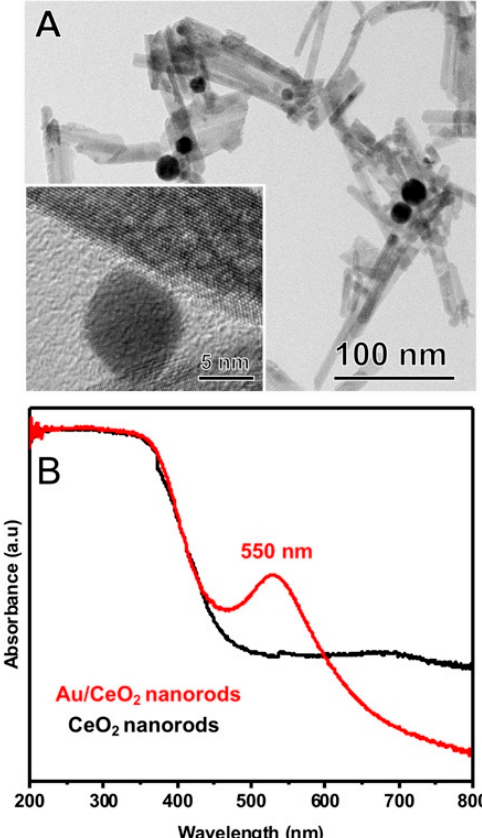
Figure 1. ( A ) HRTEM images for the Au/CeO 2 nanorods. ( B ) UV − VIS extinction spectra for CeO 2 and Au/CeO 2 nanorods (black and red traces, respectively).